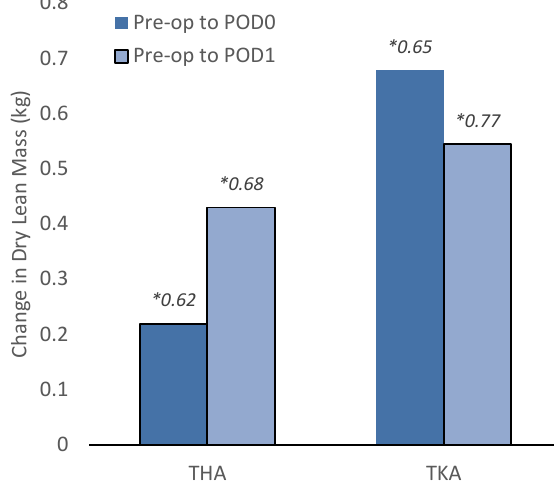
Figure 1. Comparison of means of change in dry lean mass (DLM) and procedure from the pre-operative scan on the day of surgery to post- operative day 0 (POD0) and day 1 (POD1) for total hip and knee arthroplasty. * Denotes standard deviation